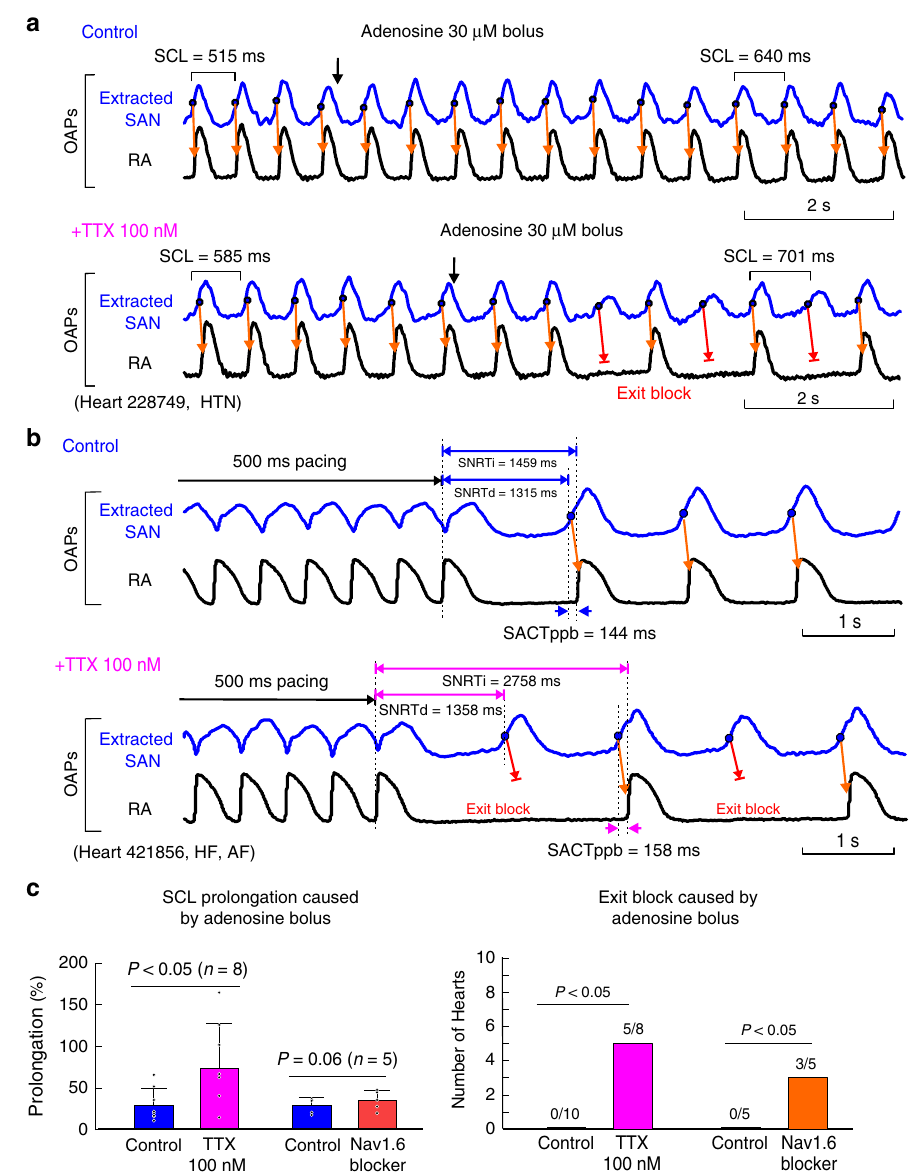
Fig. 3 Protective role of nNav in human SAN conduction during hyperpolarization and overdrive pacing. a Top: optical action potentials (OAPs) show a slight increase of sinus cycle length (SCL) during SAN hyperpolarization with 30 µ M adenosine bolus at control conditions. Bottom: OAPs show exit block from the SAN to the RA after neuronal Nav blockade with 100 nM TTX during adenosine bolus. b Top: OAPs show normal SNRT and 1:1 conduction from the SAN to the RA after 500 ms atrial pacing at control conditions; bottom: OAPs show prolonged SNRT and 2:1 exit block from the SAN to the RA after 500 ms atrial pacing during 100 nM TTX pefusion. c Left: comparison of SCL prolongation caused by adenosine bolus at control conditions ( n = 8), 30 nM nNav1.6 blocker ( n = 5), and during 100 nM TTX perfusion ( n = 8); right: exit block events observed at control conditions, 30 nM nNav1.6 blocker and during 100 nM TTX perfusion after adenosine bolus. ppb post-pacing beat, RA right atria, SAN sinoatrial node, SNRTi/d indirect/direct sinoatrial recovery time, TTX tetrodotoxin. Data of SCL prolongation in c were represented in mean ± SD, n = 8, * P < 0.05, by t -test. Analysis of exit block events used two- sided proportion test with Yates continuity correction. Source data are provided as a Source Data fi